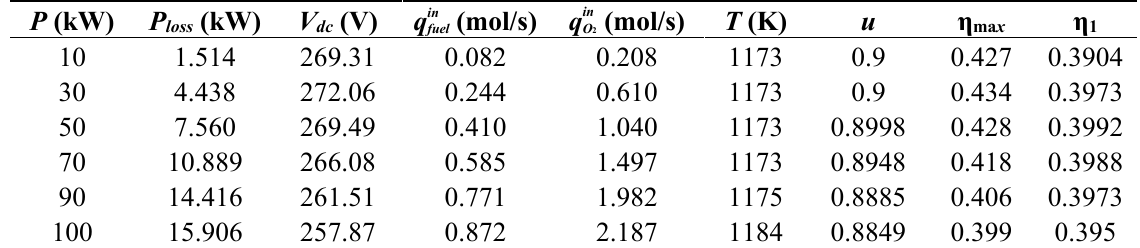
Table 2. The maximum efficiency results by nonlinear programming problem (NLPP). P